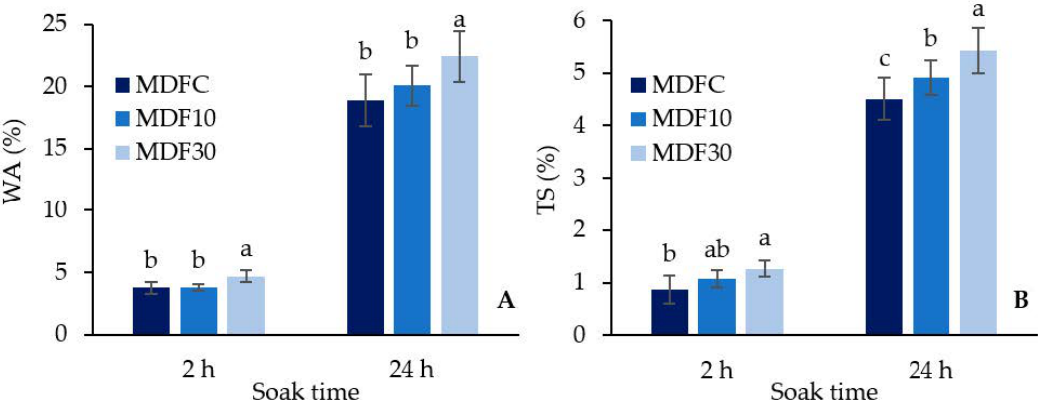
Figure 2. Dimensional stability. ( A ) Water absorption after 2 and 24 h of submersion of MDF panels. ( B ) Thickness swelling after 2 and 24 h of submersion of MDF panels. Different lowercase letters represent statistically significant difference among panels by Tukey test ( p ≤ 0.05).